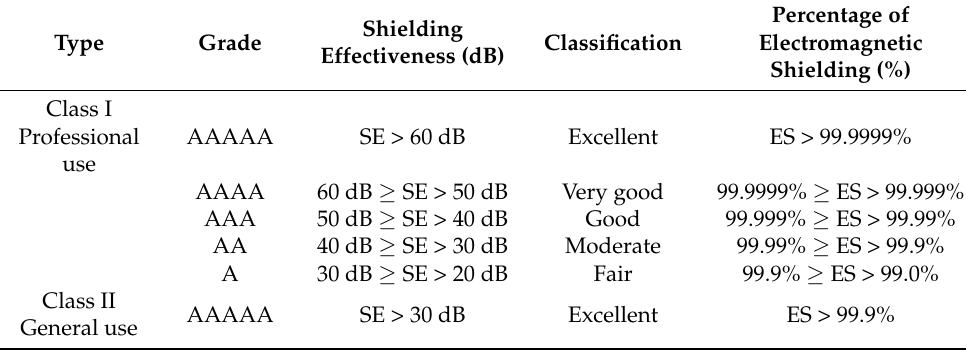
Table A1. Classification of EM SE values on textiles for general use